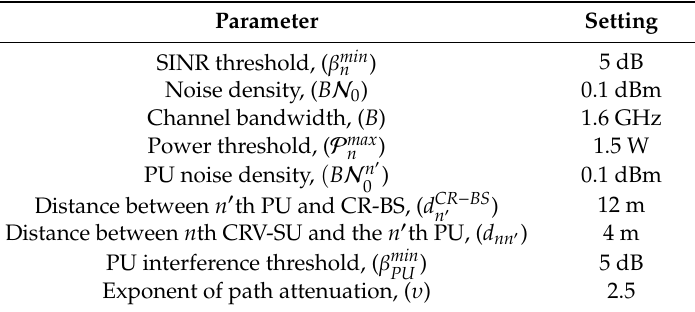
Table 3. Parameter